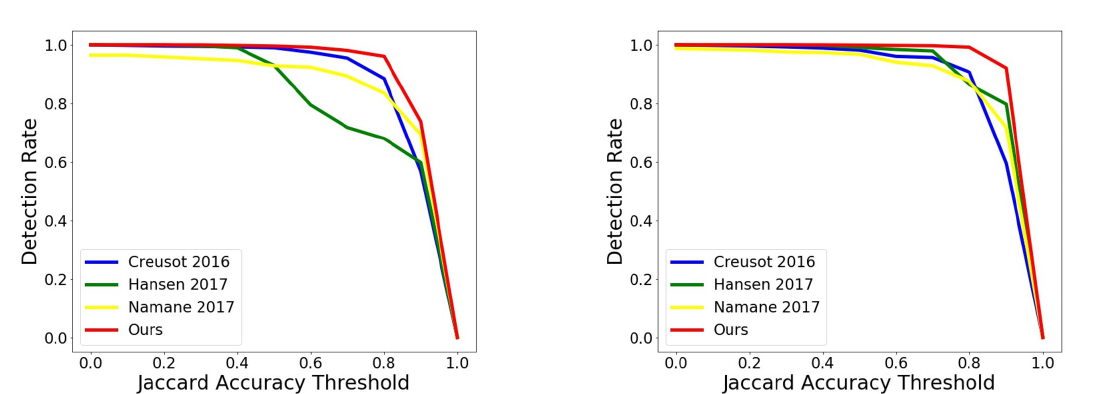
Figure 6. ( Left ): Test results on the ArteLab Rotated Barcode Dataset. ( Right ): Test results on the WWU Muenster Barcode